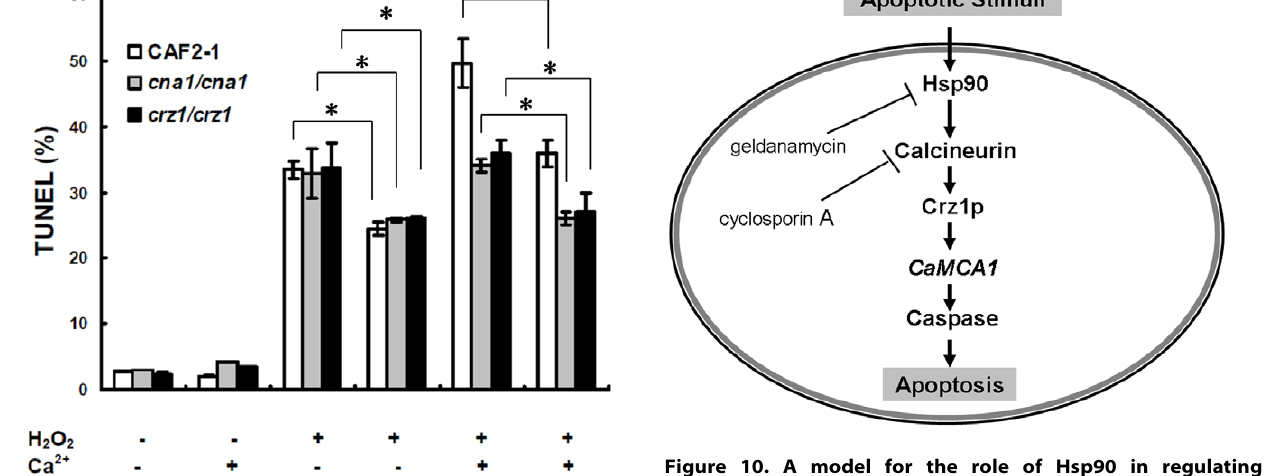
Figure 10. A model for the role of Hsp90 in regulating apoptosis in C.albicans . Upon apoptotic stimuli, Hsp90 was activated and CaMCA1 expression was elevated. Elevation in CaMCA1 expression resulted in increased caspase activity, thus inducing apoptosis. Calcineurin inhibitor cyclosporin A or Hsp90 inhibitor geldanamycin can block this pathway.